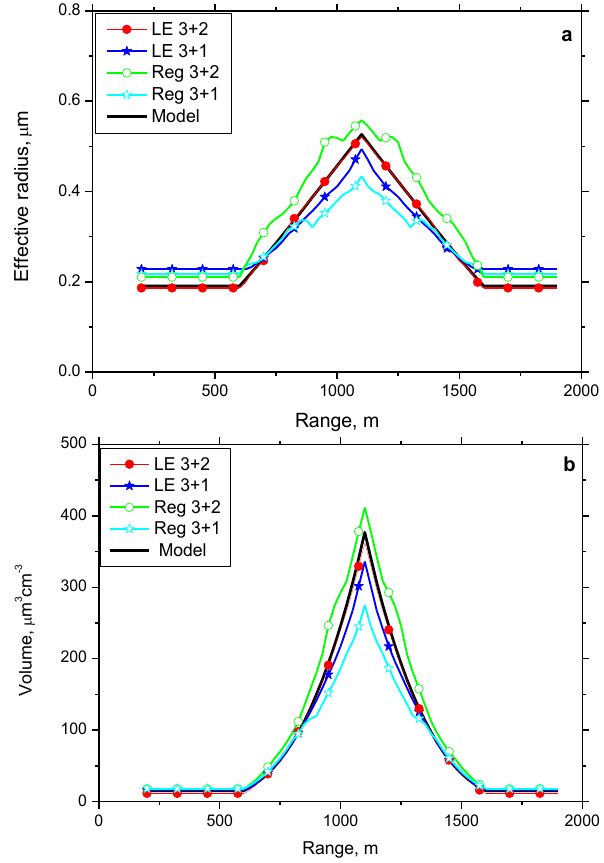
Fig. 3. Retrieval of range-dependent (a) effective radius and (b) volume density from synthetic optical data. Results are given for regularization and LE techniques applied to 3 β + 2 α and 3 β + 1 α measurements. The black solid line shows the model particle pa- rameters. The input optical data are free of errors.